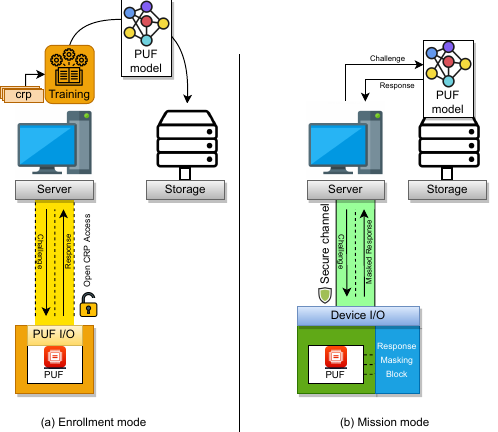
Figure 1. Schematic of a communication between PUF and a verifier server, via an estimation model of